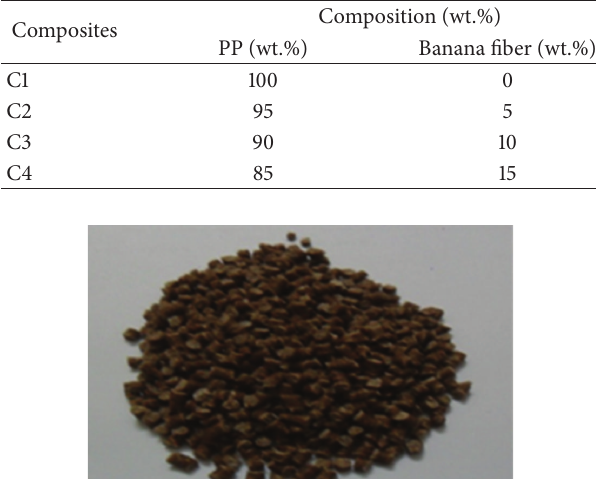
Table 1: Composition of different composites.